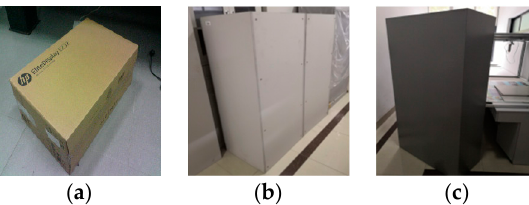
Figure 19. Errors between the standard box and the measured result.